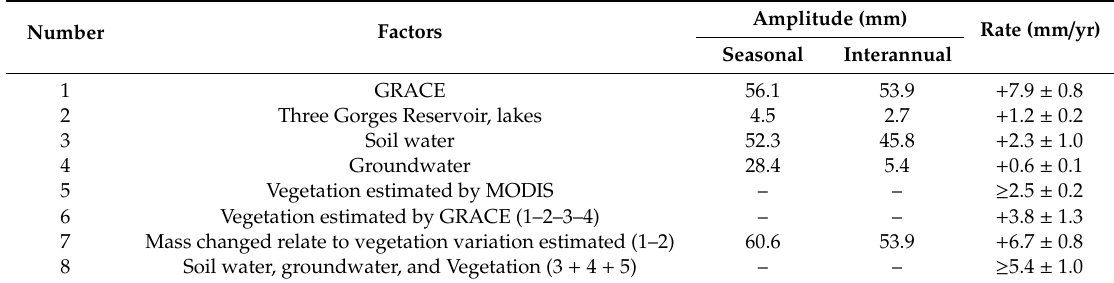
Table 1. Mass change rate of each factor within the study